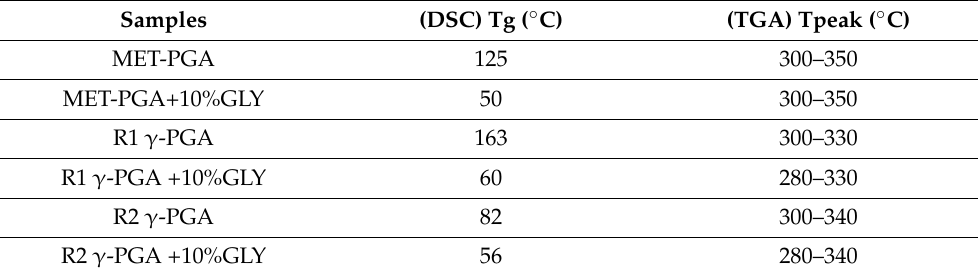
Table 3. Glass transition temperatures (Tg) and the starting endothermic peak (Tpeak) of all the